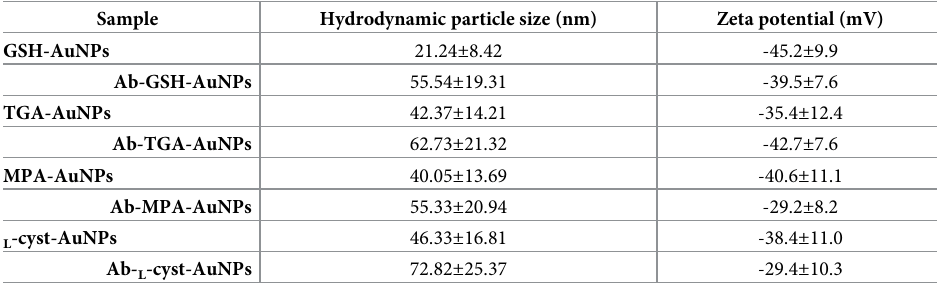
Table 1. Hydrodynamic sizes and Zeta potential values of the thiol-capped AuNPs and the